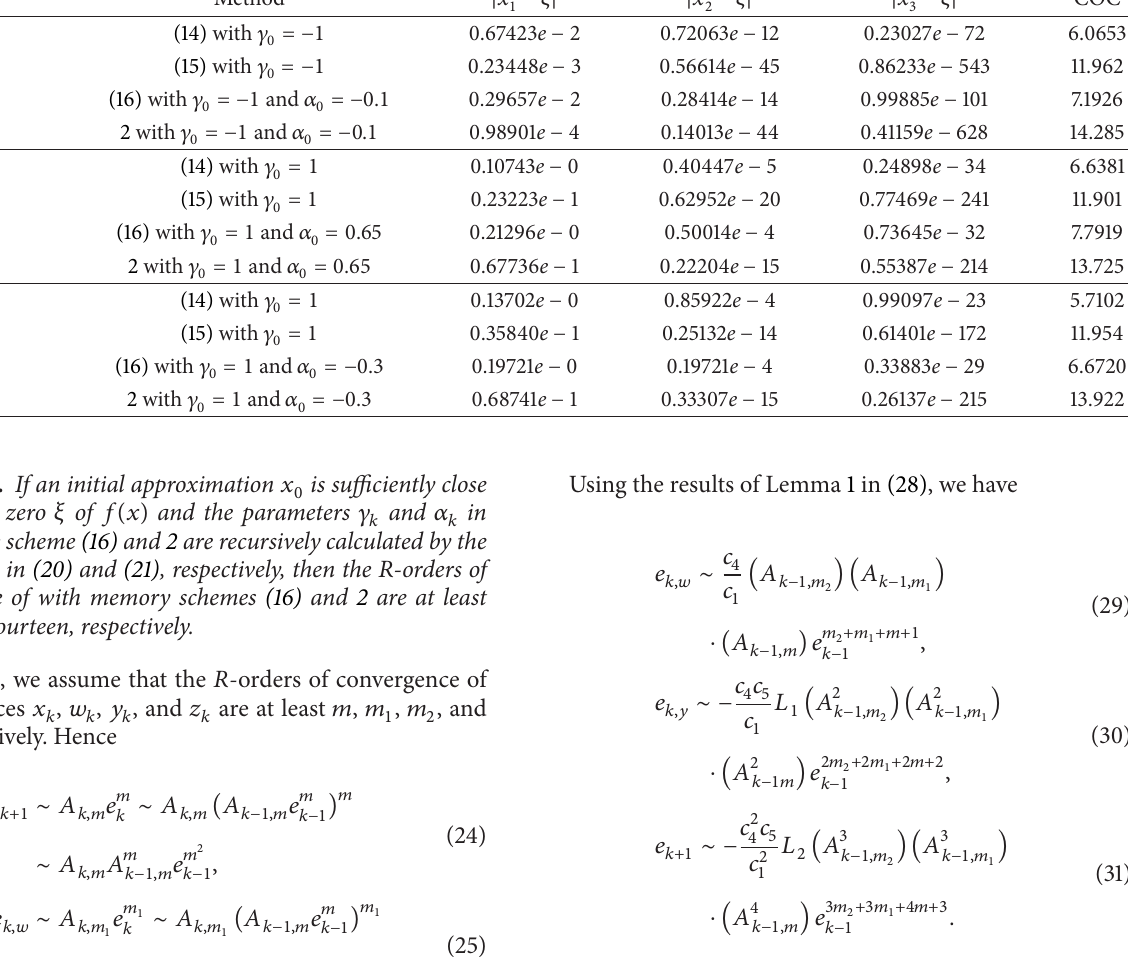
Table 1: Comparison of the absolute error in first, second, and third iteration.